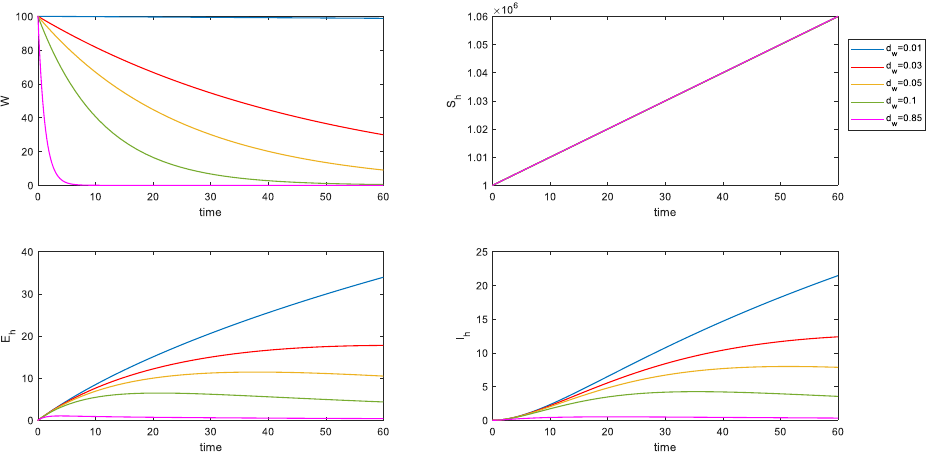
Figure 3. Changes in the number of W , h S , h E , and h I with different w d in model 1.